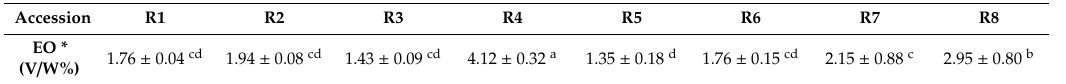
Table 1. Essential oils (EOs) content of the eight accessions.